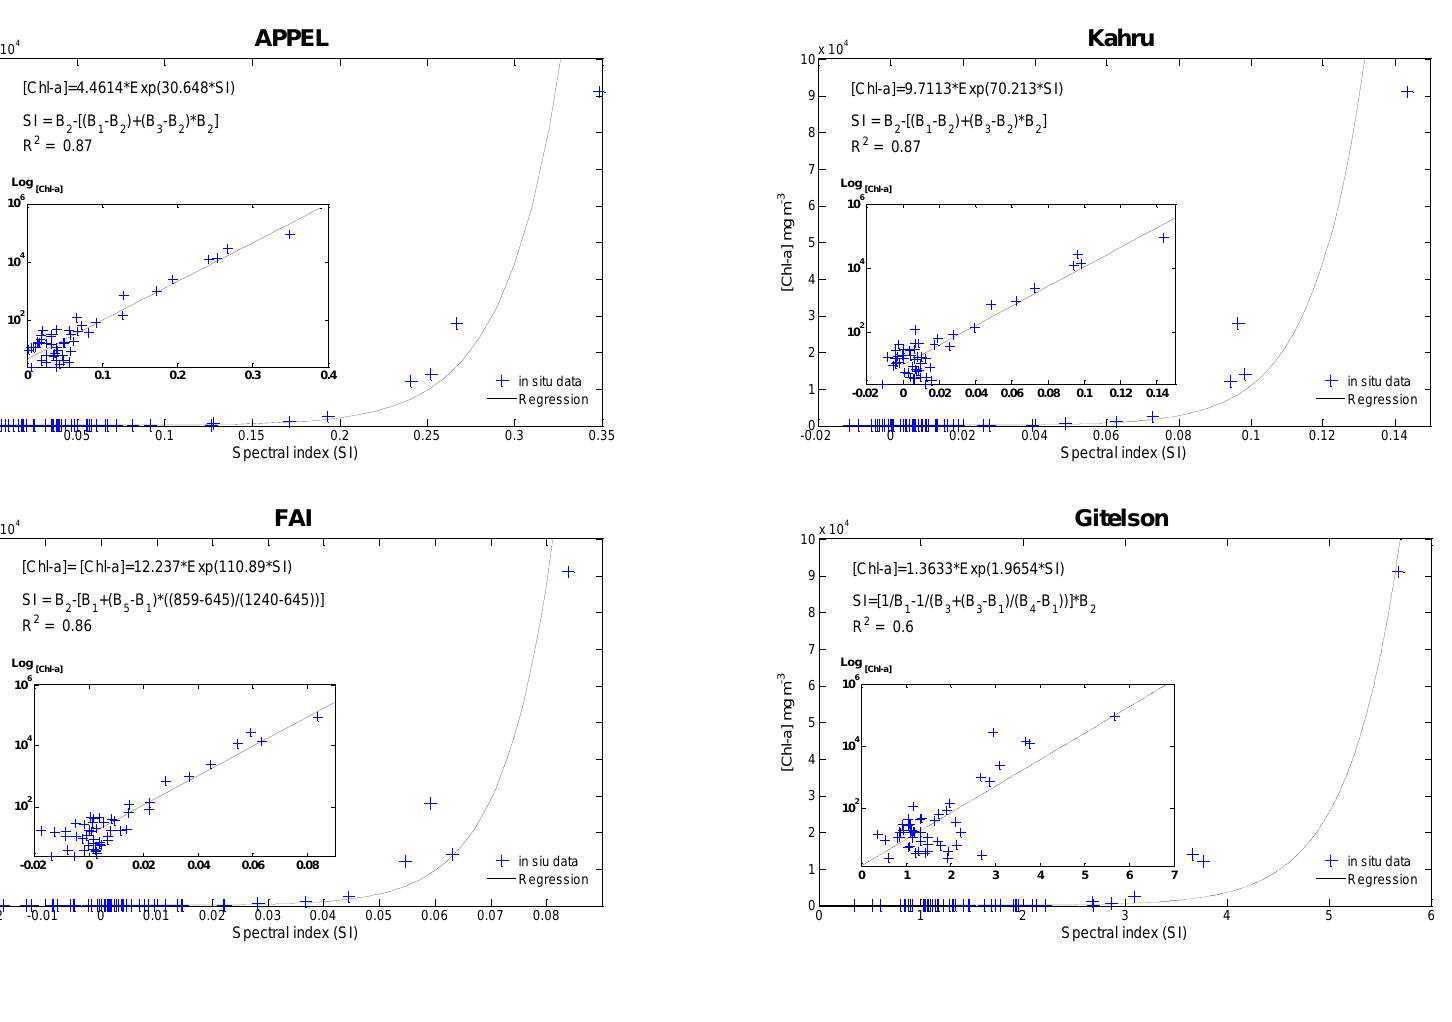
Figure 5. Exponential regression obtained between chlorophyll-a concentration (whole data set) and the outputs of the MODIS reflectance bands for the four models (y-axis of inserts is on a logarithmic